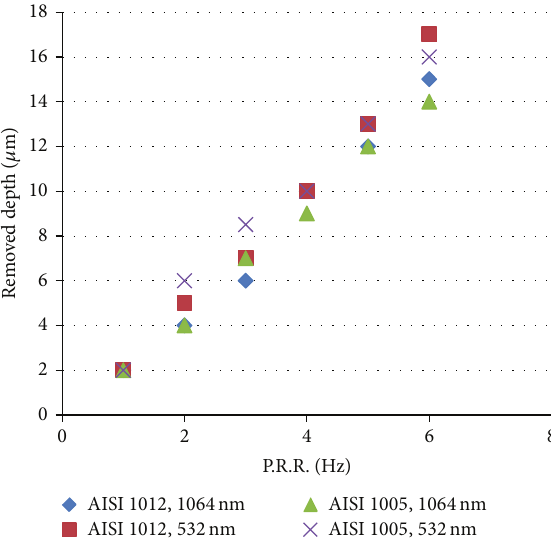
Figure 8: Variation of depth as a function of PRR at 𝑃 𝑝 40 MW.